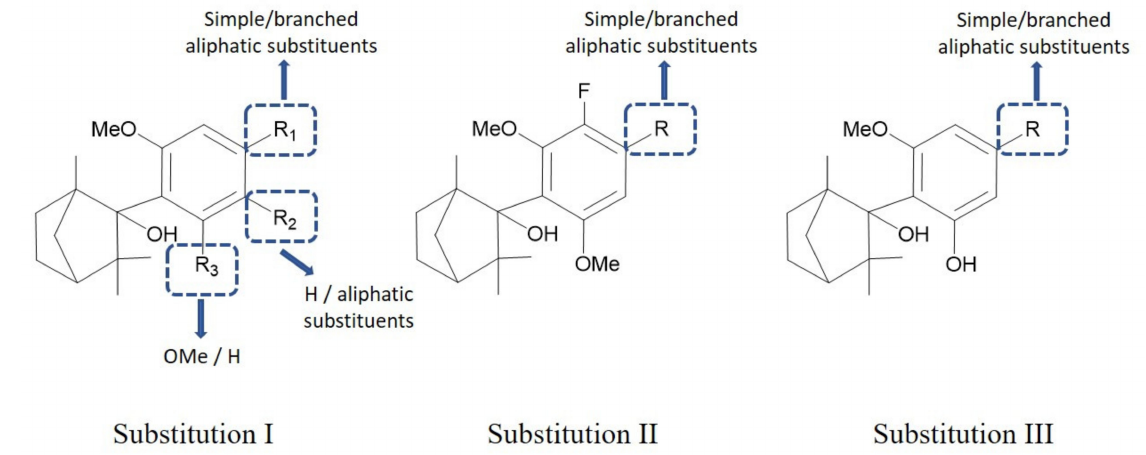
Figure 2. Structural modifications employed in the SAR